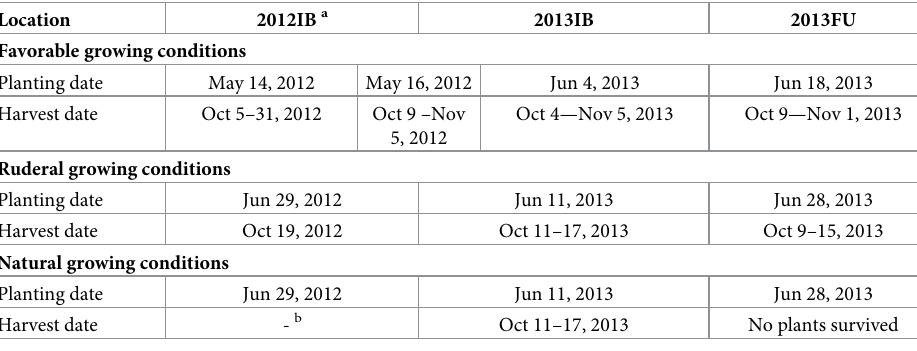
Table 2. Planting and harvest dates for trials in 2012 and